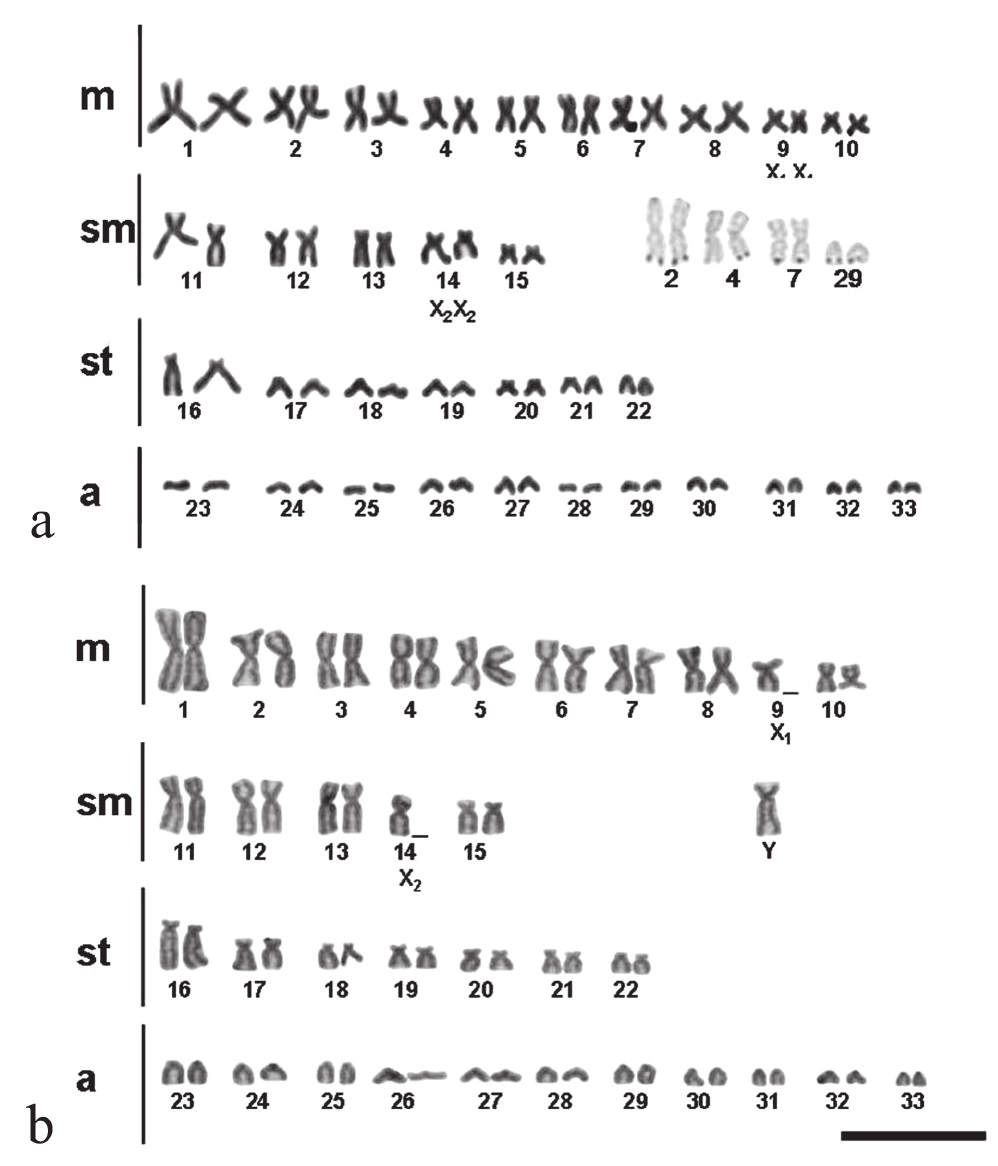
Fig. 4. Karyotypes of female ( a ) and male ( b ) of Potamotrygon falkneri sample from Porto Rico, highlighting the sex chromosomes after conventional and the chromosomes marked by NOR. Scale bar = 10 